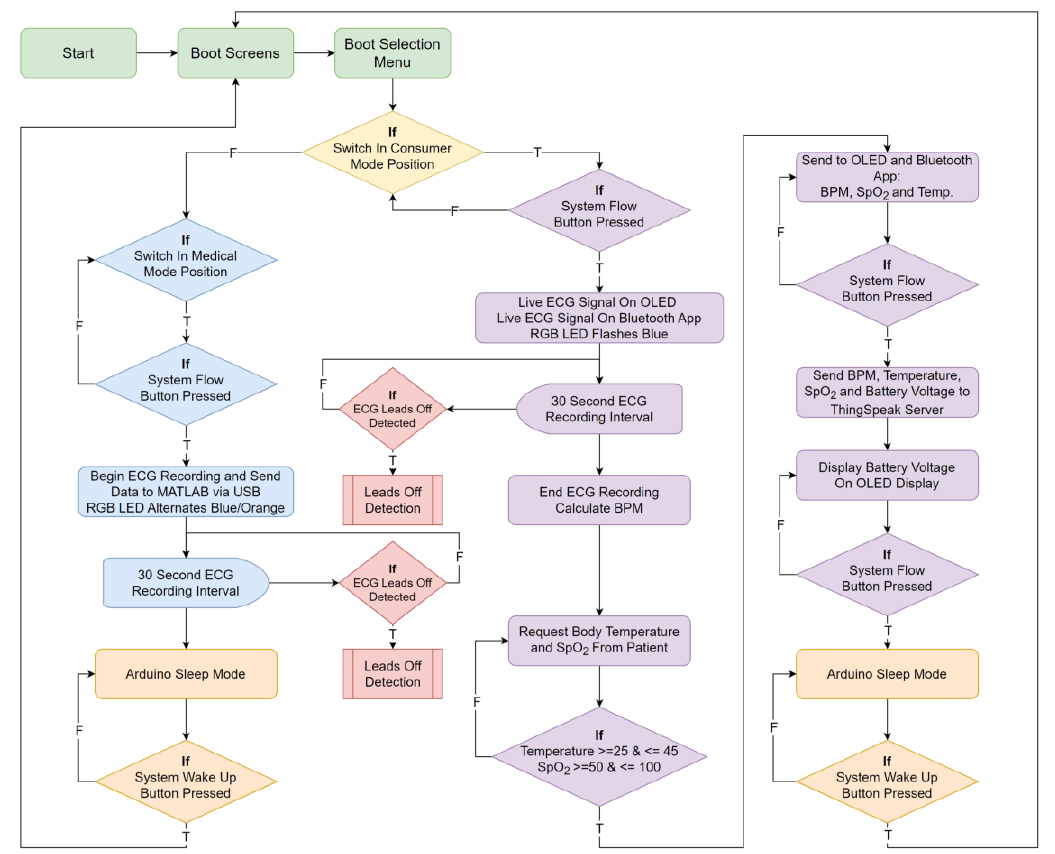
Figure 5. System level flow diagram. “F” represents the action if the condition is false, while “T” represents the action if the statement is true.